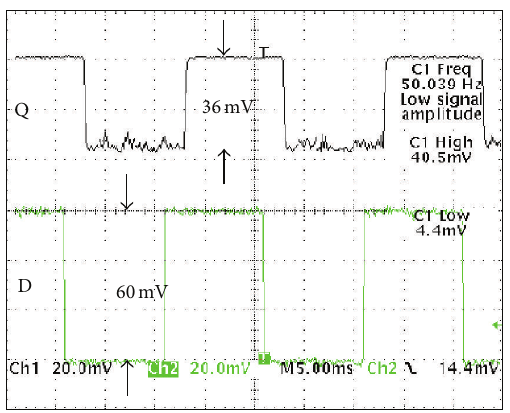
Figure 10: Waveforms of the C2DPFF at 60mV